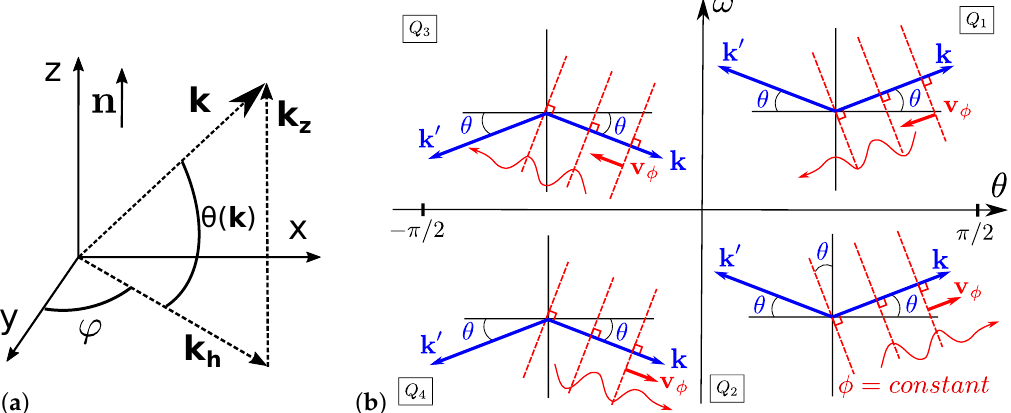
Figure 1. ( a ) Frame of reference in a polar-spherical system of coordinates attached to the vertical unit vector n which applies in both physical and spectral spaces. k is the vector of the considered wave or spectral mode, k h its component in the horizontal plane, k v its component in the vertical axis, θ its radial angle and ϕ its azimuthal angle. ( b ) Diagram representing the four possibilities Q 1 , Q 2 , Q 3 , Q 4 of the propagation of the crest of constant phase φ = k · x + ω t = constant in the plane ( θ , ω ) (see text for explanation). To generalize our analysis, we introduce k (cid:48) = ( − k x , − k y , k z ) as the horizontal opposite of k and sharing the same angle θ